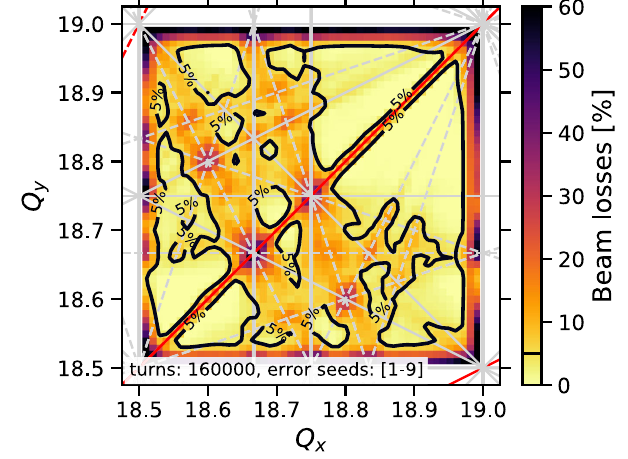
FIG. 6. Beam-loss tune diagram for vanishing space charge and all magnet field errors included at natural